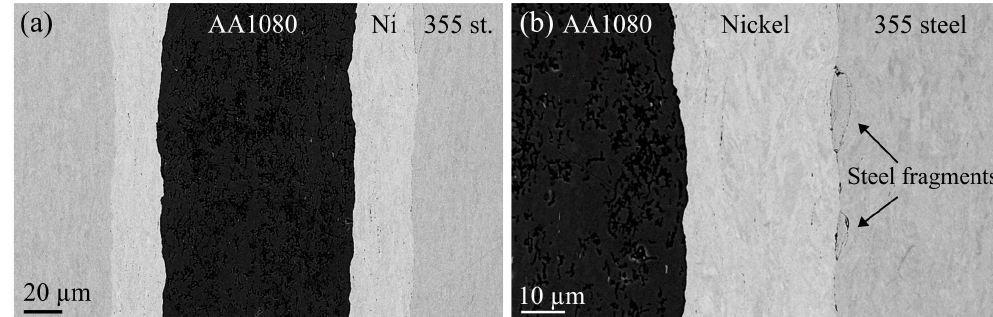
Figure 2. Scanning electron microscopy (SEM) images of the cross-section of a composite after rolling. ( a ) shows the whole composite with aluminum (dark grey) in the center, nickel (light grey) on each side of the aluminum, and steel (grey) as the outer layers. In ( b ), examples of the steel fragments that could be observed along the steel-nickel interface are highlighted.